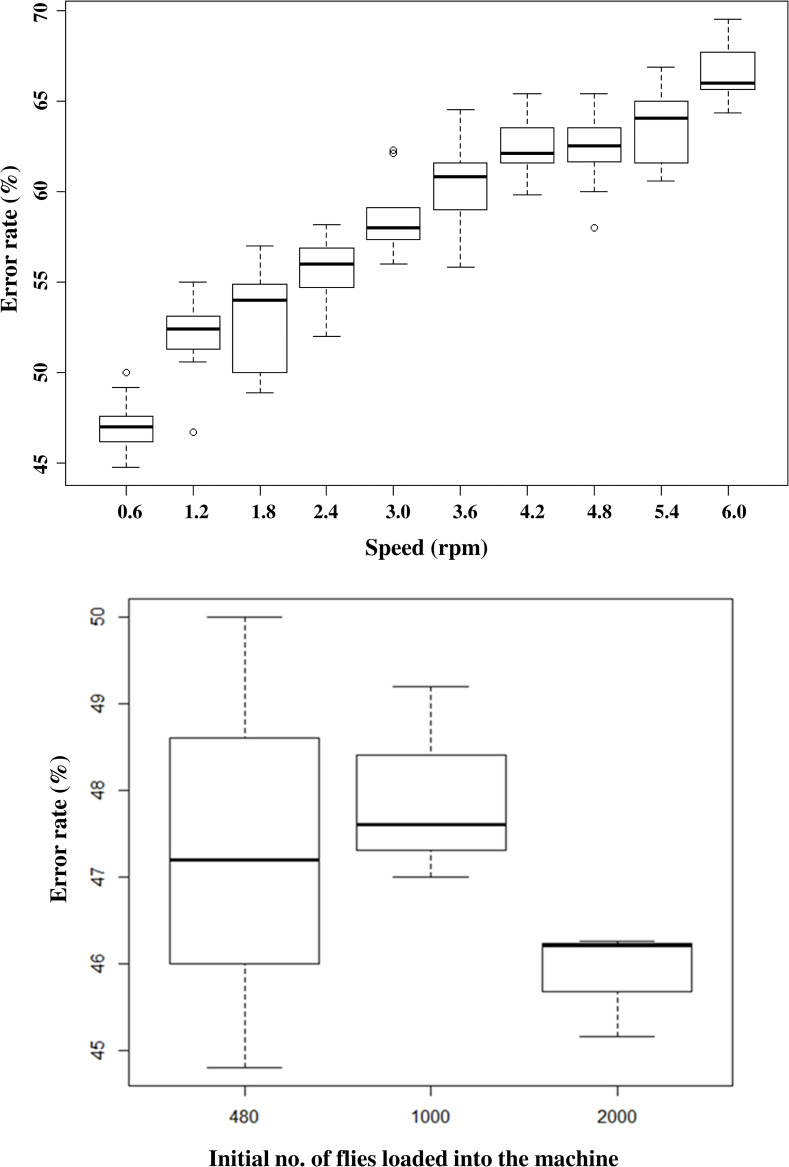
Effect of motor speed and initial fly number on the error rate of the BSITM.A, Impact of motor speed (rpm) on the error rate during counting of the sterile males released by the BSITM; B, Impact of initial number of flies on the counting error rate during the counting of sterile males released by the BSITM at the lowest speed (0.6 rpm). Five-day old sterile males G. p gambiensis were immobilized at 4°C and loaded into the BSITM and released. The difference between the number of males counted by the BSITM and the hand counts was recorded as the error rate. The graphs represent the minimum, first quartile, median, third quartile and maximum for each treatment.